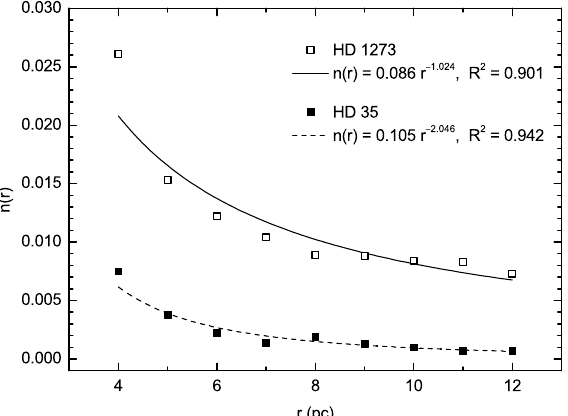
Fig. 3. Power-law dependence of stellar density on the radius of the sphere centered on HD 1273 and HD 35. Here R 2 is the Pearson significance of the